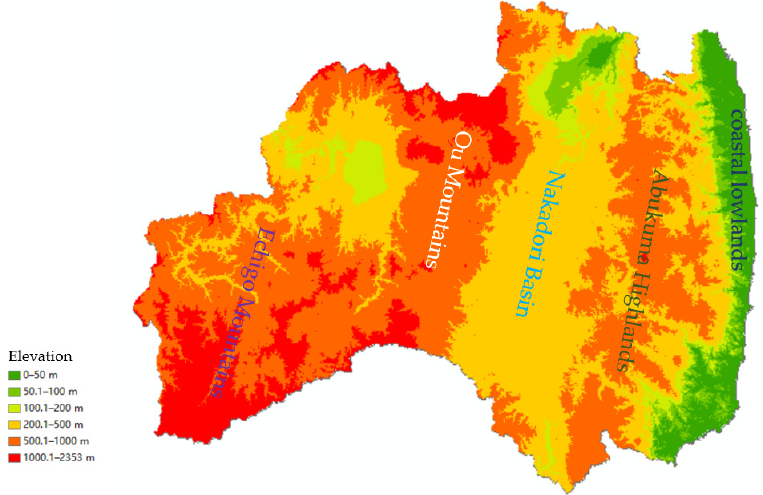
Figure 6. Topographical map of Fukushima prefecture.